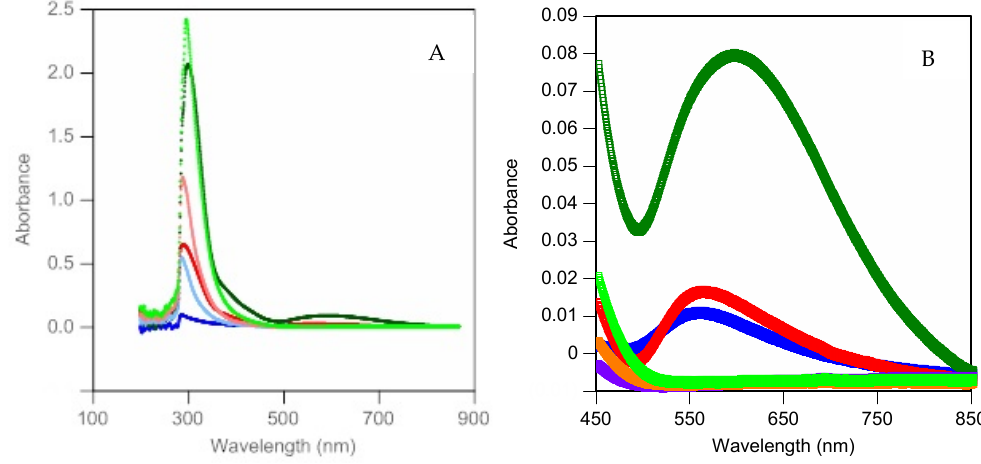
Figure 7. Absorption spectrometry analysis of the effect of gold (III) concentration on gold removal by C. krusei AHU3993. Gold removal conditions were identical to that in Figure 5. Symbols: Green line: 200 mg Au/L; red line: 100 mg Au/L; blue line: 50 mg Au/L. Light colors indicates gold (III) in the original solution, and each dark color indicates gold (III) levels after treatment. ( A ) Wavelength rom 200–870 nm, ( B ) Wavelength from 450–850 nm. Light blue line: initial 30 mg/L gold (III) solution; blue line: incubation with 30 mg/L gold (III) solution; light red line: initial 50 mg/L of gold (III) solution; red line: incubation with 50 mg/L gold (III) solution; light green line: initial 200 mg/L of gold (III) solution; green line: incubation with 200 mg/L gold (III) solution.